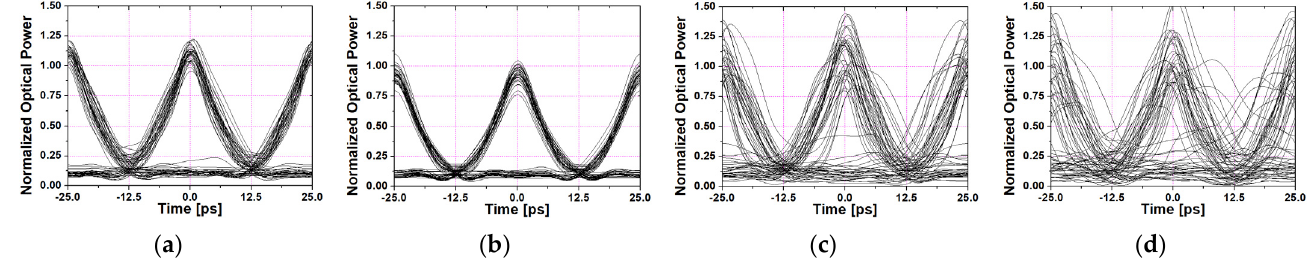
Figure 2. The eye diagrams. ( a ) conventional scheme, ( b ) random-inverse distribution, ( c ) random- follow distribution, and ( d ) all-random distribution. follow distribution, and ( d ) all-random